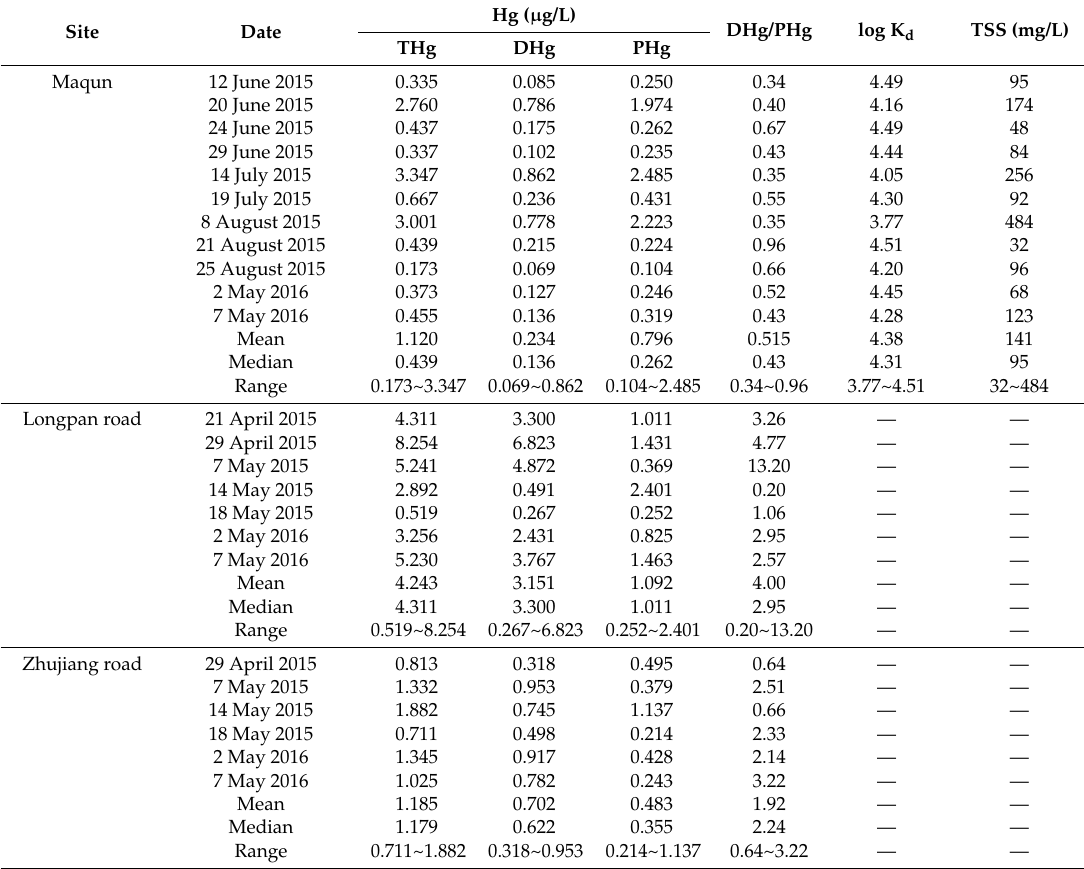
Table 4. Event mean concentrations (EMCs) of Hg pollution in urban storm water runoff.